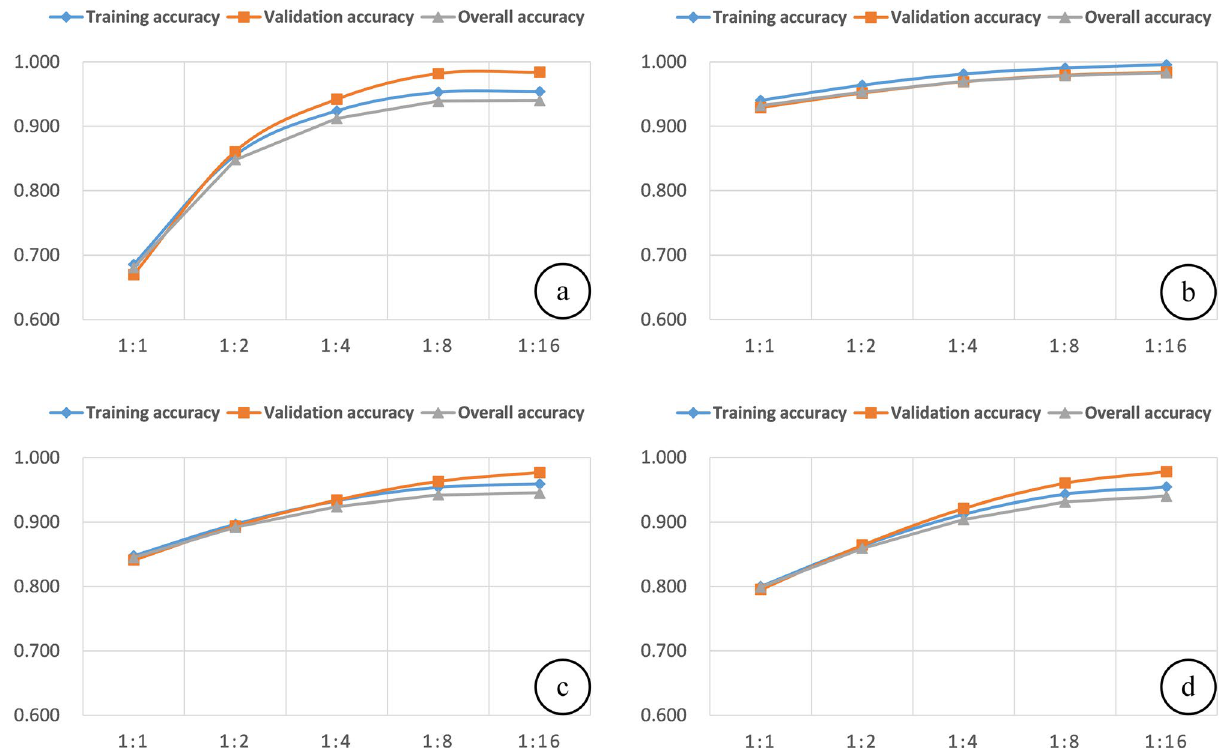
Figure 13. Training accuracy and validation accuracy of ( a ) CNN model, ( b ) C5.0 model, ( c ) SVM model, ( d ) LR